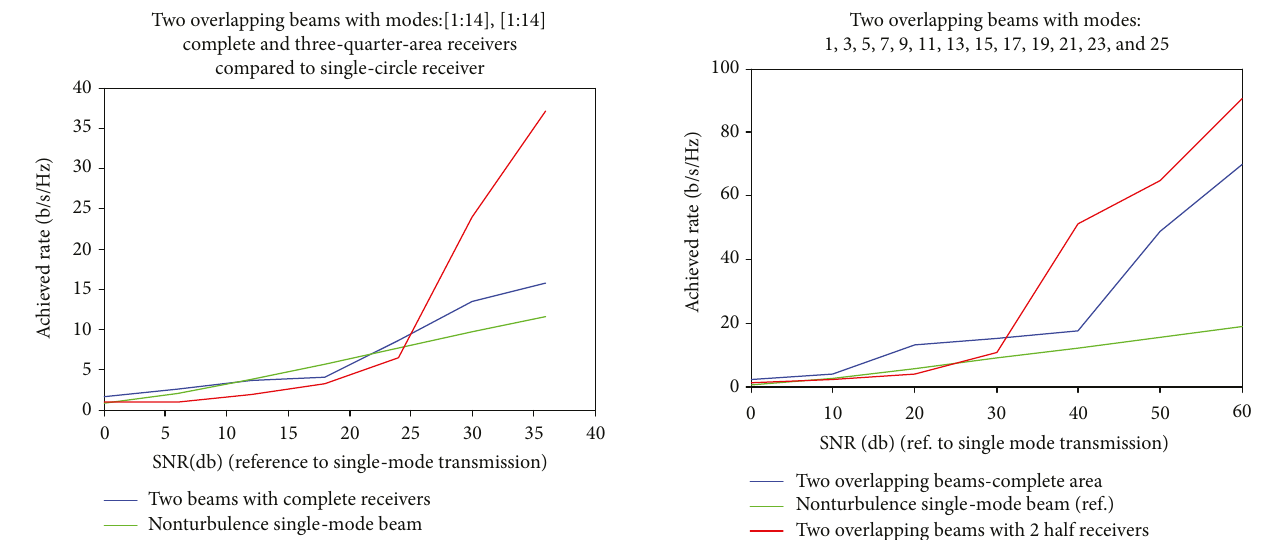
= 10m , l = 1 cm , alpha =3.1, 0 0